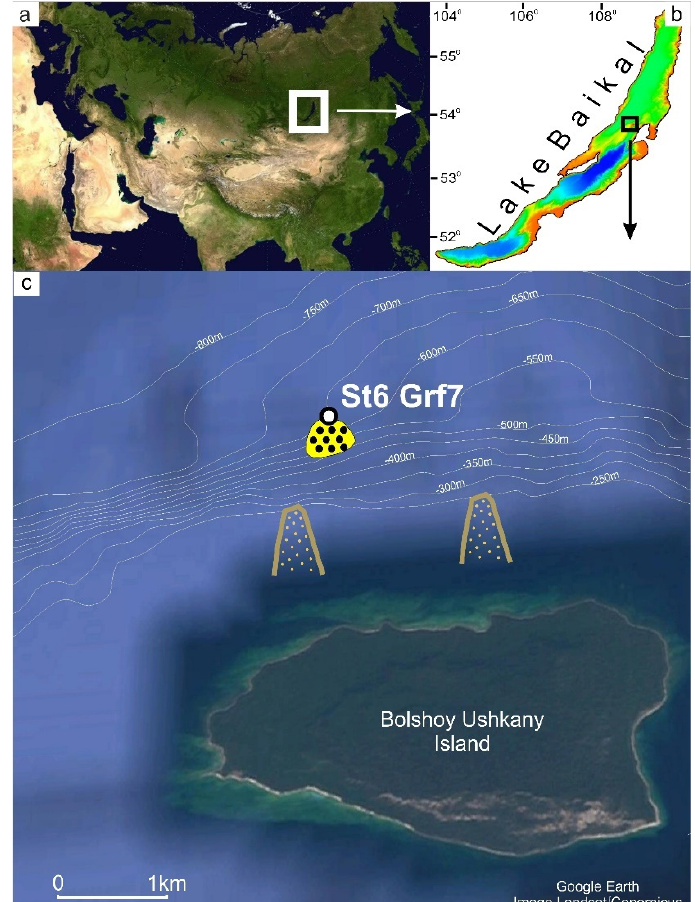
Figure 1. (a) Geographic location of Lake Baikal; ( b ) Geographic location of Bolshoy Ushkany Island; ( c ) Area of sampling sediments and Fe-Mn deposits (St6 Grf7). Light brown shows the slope slides.